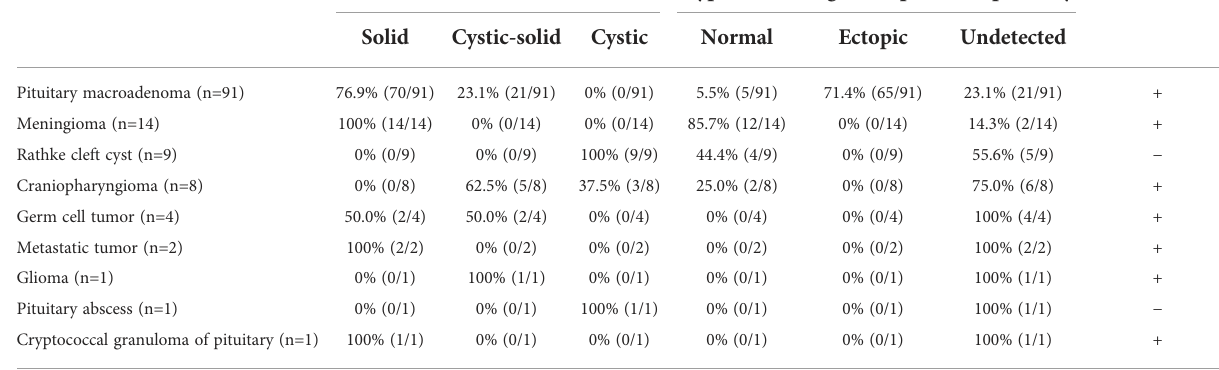
TABLE 1 The imaging features of different sella area diseases. Sellar